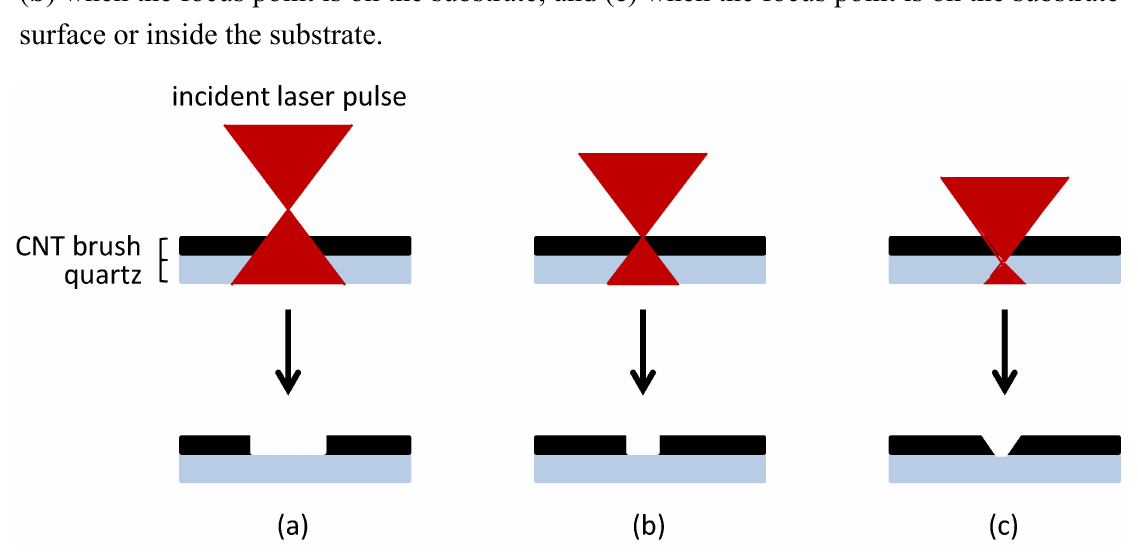
Figure 2. Schematic view of the interaction between the laser spotlight and the sample